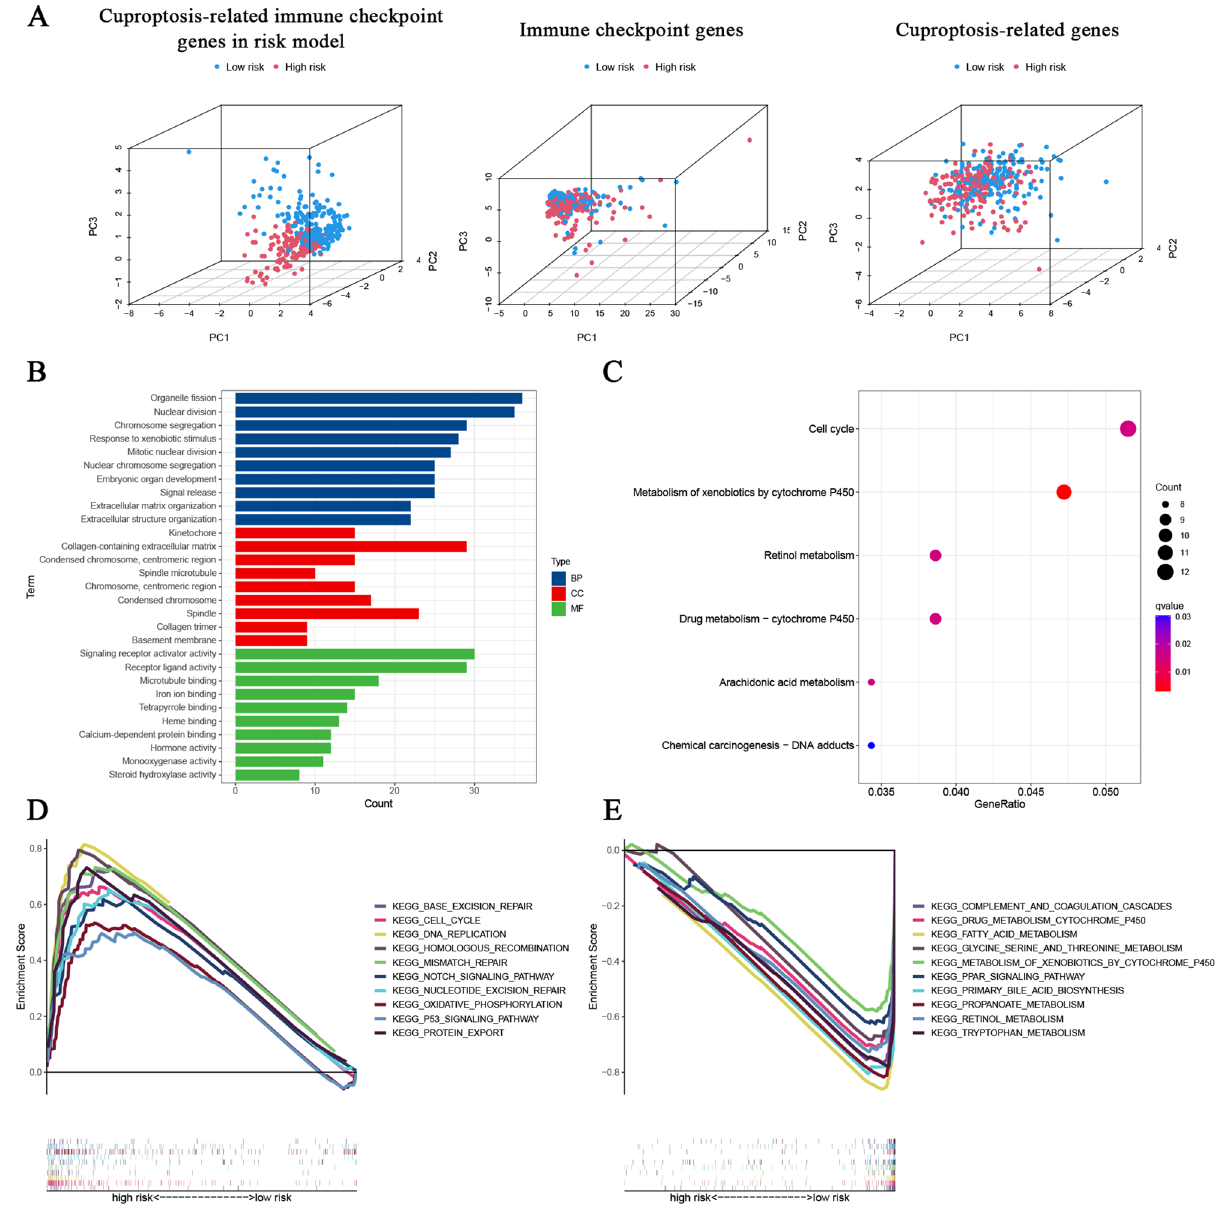
Figure 6. Functional analyses of cuproptosis ‐ related ICGs prognostic signature. ( A ) The PCA scatterplot of sample 3D distribution. ( B ) GO and ( C ) KEGG enrichment analysis of risk differential genes. ( D , E ) GSEA analysis of prognostic